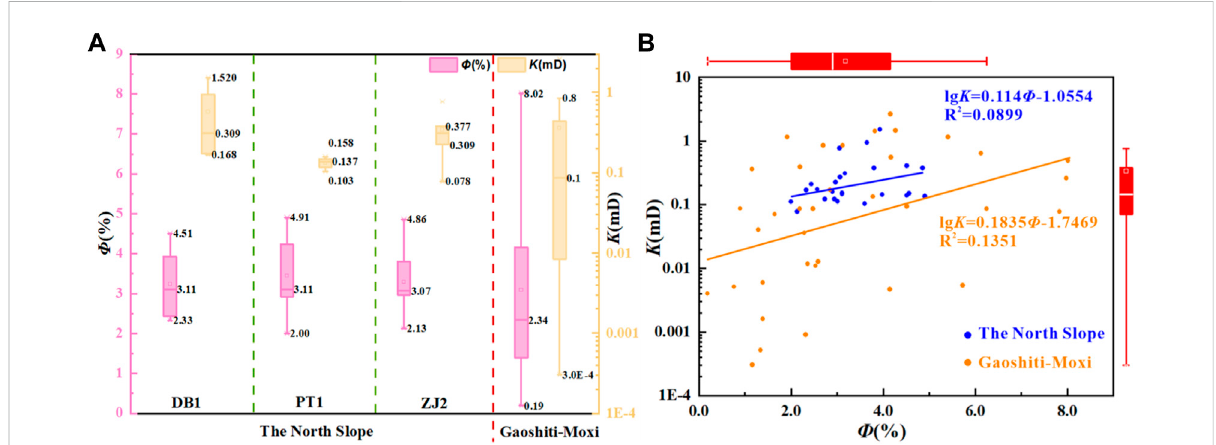
FIGURE 7 (A) Routine physical properties analysis for core samples from the North Slope and the Gaoshiti-Moxi area; (B) A scatter plot showing the correlation between porosity and permeability. A comparison of the physical properties of Dengying reservoir rocks from the North Slope and Gaoshiti-Moxi.